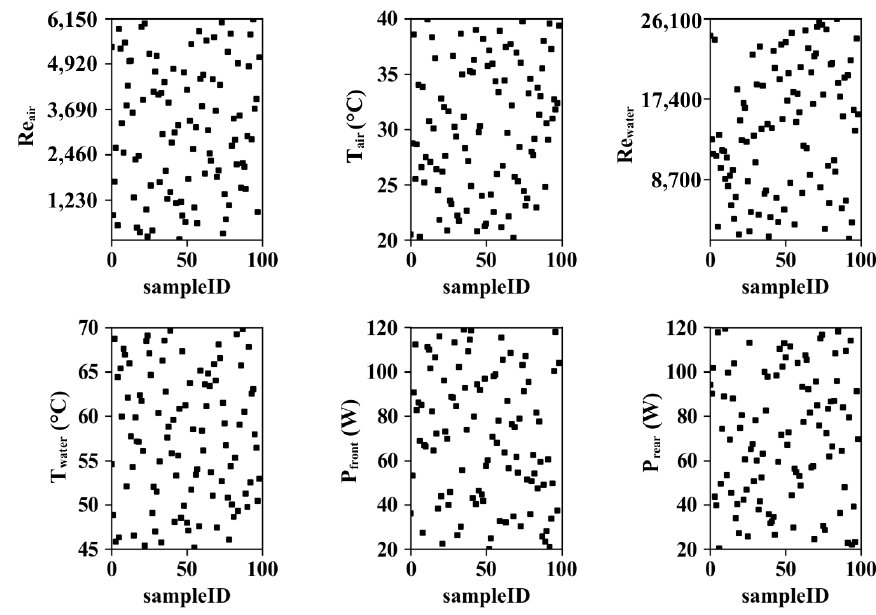
Figure 15. The dataset generated by the LHS method.